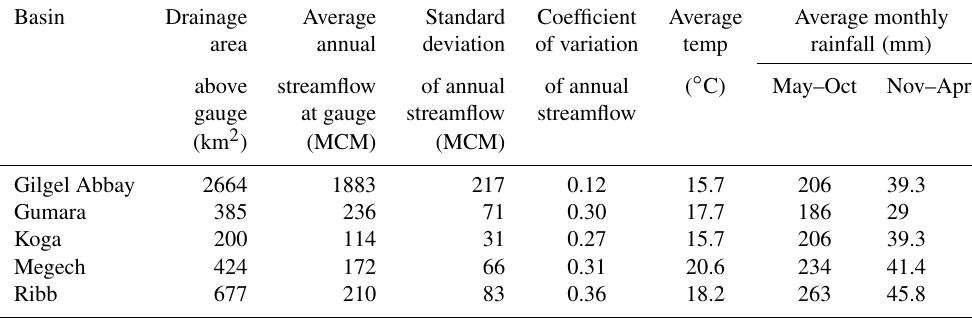
Table 1. Study basin characteristics over the evaluation period of 1961–2004. Basin Drainage Average Standard Coefficient Average area deviation of variation temp rainfall ( mm )